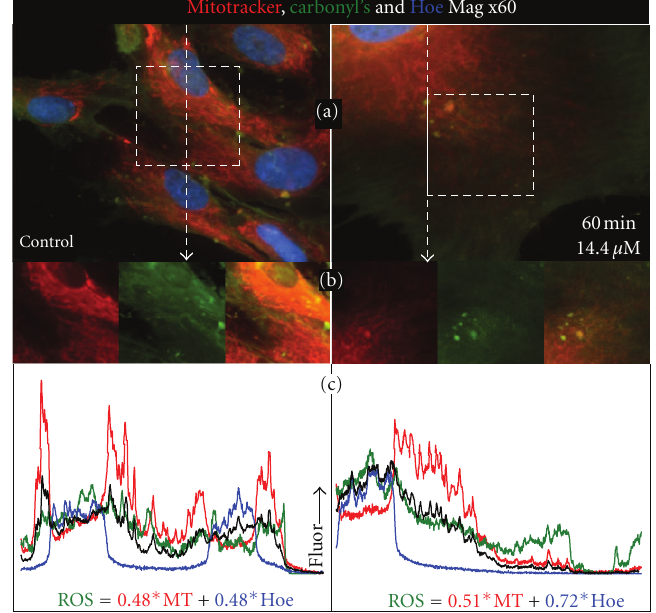
Figure 3: Colocalization of Mitotracker and carbonyls in normal human astrocytes. Thimerosal induces oxidative damage at the mitochondrial level. Control and 14.4 µ M Thimerosal-treated cells prepared using MT (red) and Hoechst (blue), with FITC-Avidin/Biotin- Hydrazide carbonyl labeling (green). (a) A large ethylmercury-treated cell showing an increase in green ROS damaged cell contents as a function of distance from the nucleus. (b) Two boxes from (a) highlighting the correlation between MT (red) and carbonyl (green) signals. (c) The two vertical lines in (a) indicate the position of fluorophore intensity profile interrogation. Red: MT, green: carbonyls, blue: Hoechst, black: a simulation of the levels of ROS damage generated by combining fractions of the MT and Hoechst signals. In both samples the simulation is a poor match for the actual ROS-induced signal, with cross-correlations of ROS versus simulation giving R 2 values of only 0.68 and of 0.86, respectively.